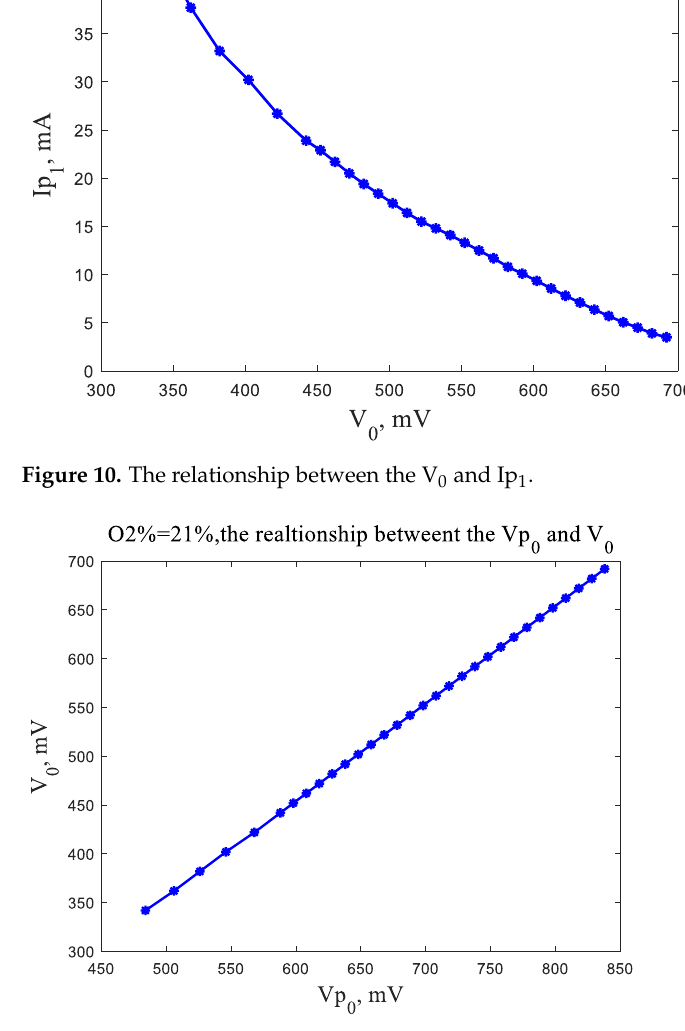
Figure 11. The relationship between the V 0 and Vp 0 .